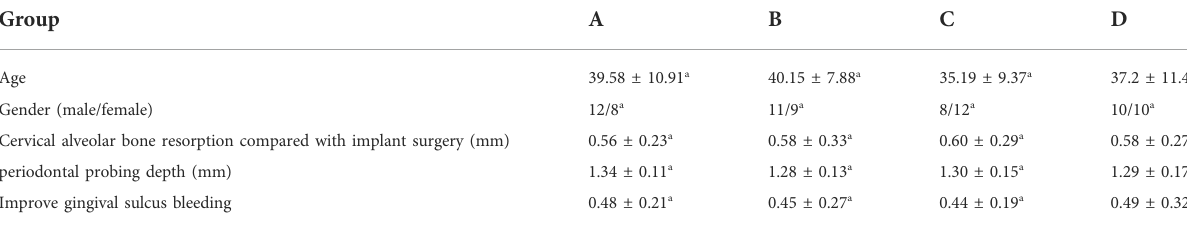
TABLE 1 Baseline characteristics of patients in each group after implant restoration. Group